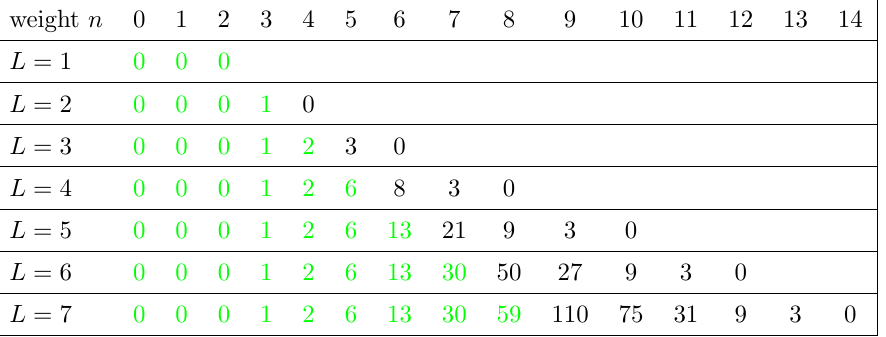
Table 9 . Same as table 8, but just the parity odd f n; 1 ; 1 ; : : : ; 1 g coproducts of the MHV amplitude. Note that saturation of the odd functions begins one loop earlier.